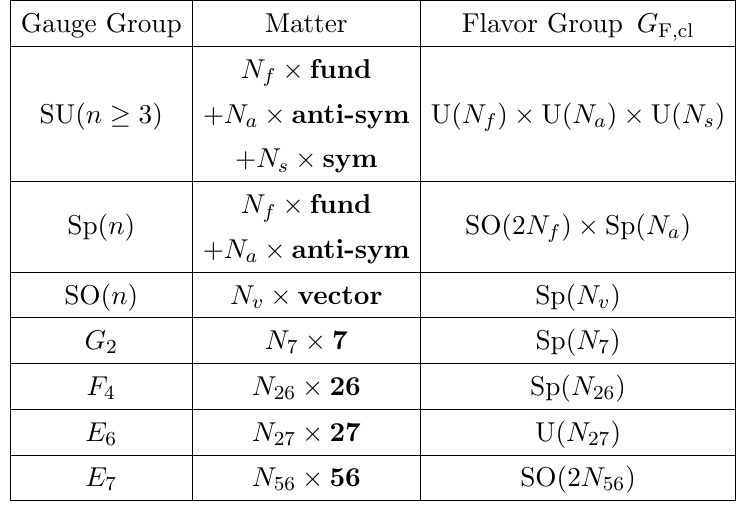
Table 1. Flavor symmetries of 5d gauge theories with simple gauge groups. The matter content has been restricted to representations that allow for the gauge theory to have an honest 5d SCFT limit. For this reason, there is no E 8 theory with non-trivial matter in this table. Note that for SU( n (cid:21) 3) gauge theories, the N i hypermultiplets transforming in the (anti-)fundamental of the SU( N i ) (cid:26) U( N i ) (cid:13)avor factor have charges ( (cid:0) )1 under the baryonic U(1) (cid:26) U( N i